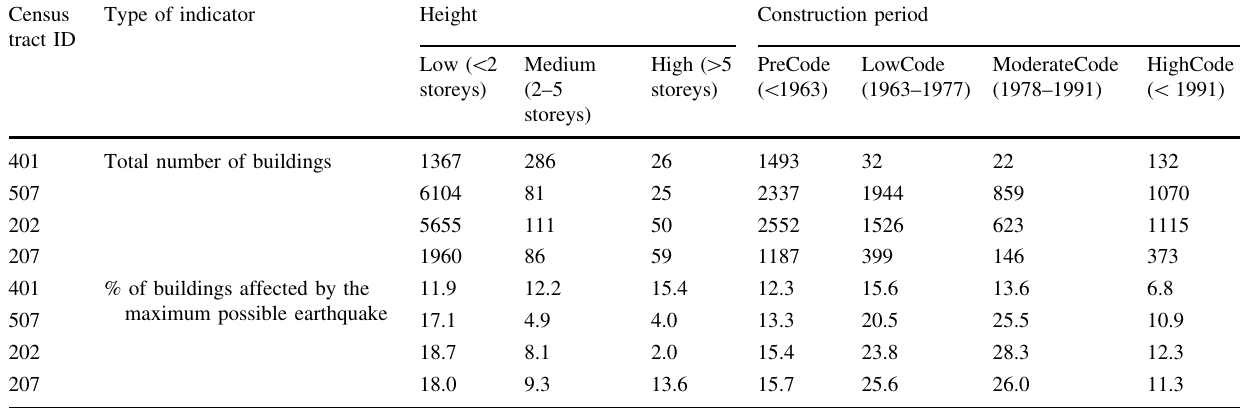
Fig. 7 Graph of the ranking fluctuations when uncertainty in the criteria scores is considered ( ± 30% in scores uncertainty; Monte-Carlo analysis with 10,000 simulations). The map in the right corner locates the four most vulnerable census tracts selected for the uncertainty